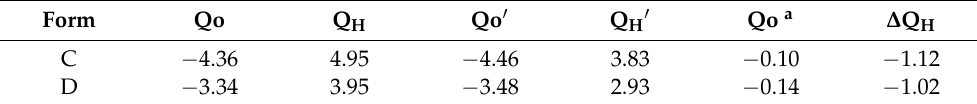
Table 7. Charge transfers (e) of O and H in hydrated Fe(OH) 2+ in compounds C and D.